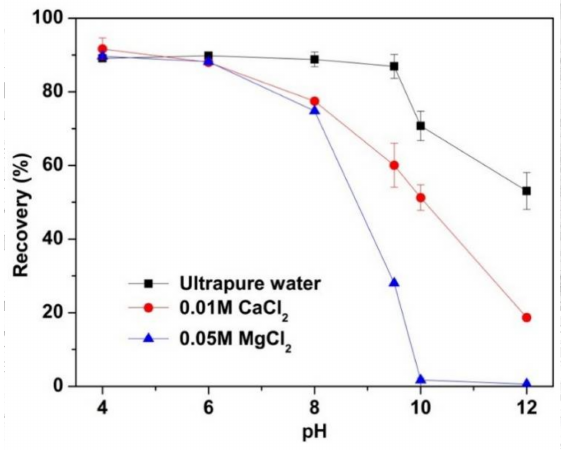
Figure 2. Chalcopyrite recovery as a function of